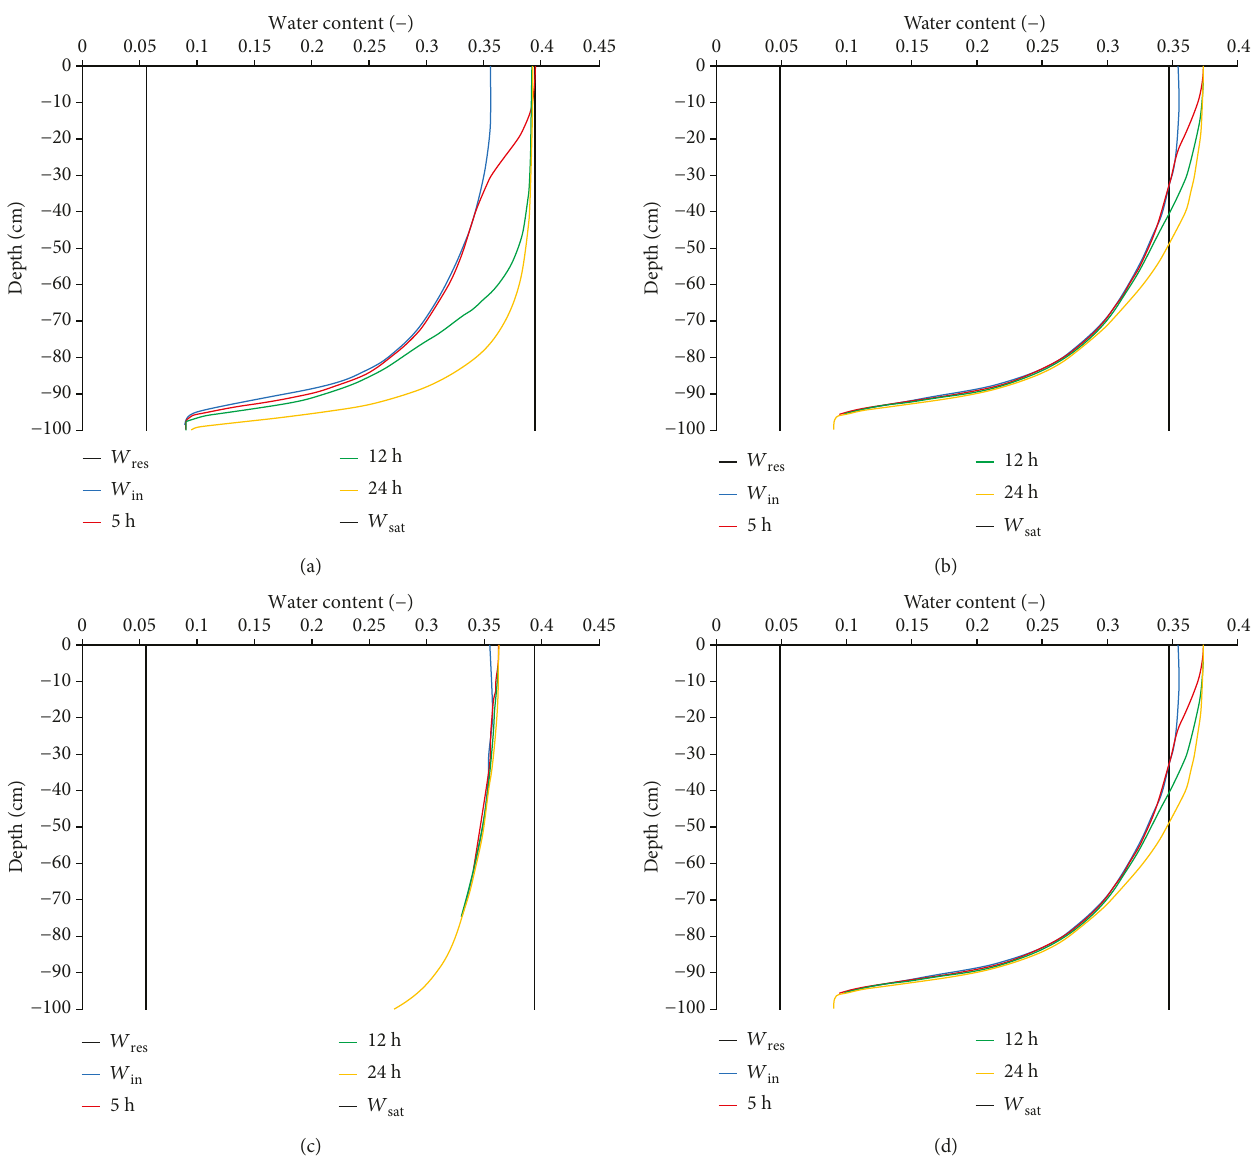
Figure 11: Water content trend vs. depth resulting from the HYDRUS-1D simulation of the January 31-February 1, 2014, rainfall event that occurred in Rome. Each graph refers to one of the soil types outcropping on Monte Mario Hill: (a) clayey sand (SC); (b) lean clay (CL); (c) silt (MH); (d) silty sand (SM). Legend: W res : residual water content; W in : initial water content; W sat : saturated water